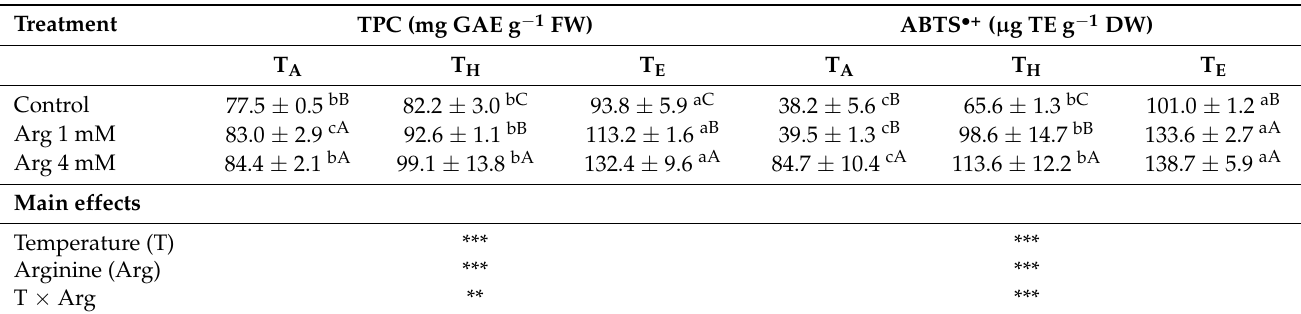
Table 6. Antioxidant activity and total phenolic compounds (TPC) of cauliflower florets affected by short-term heat stress and foliar arginine